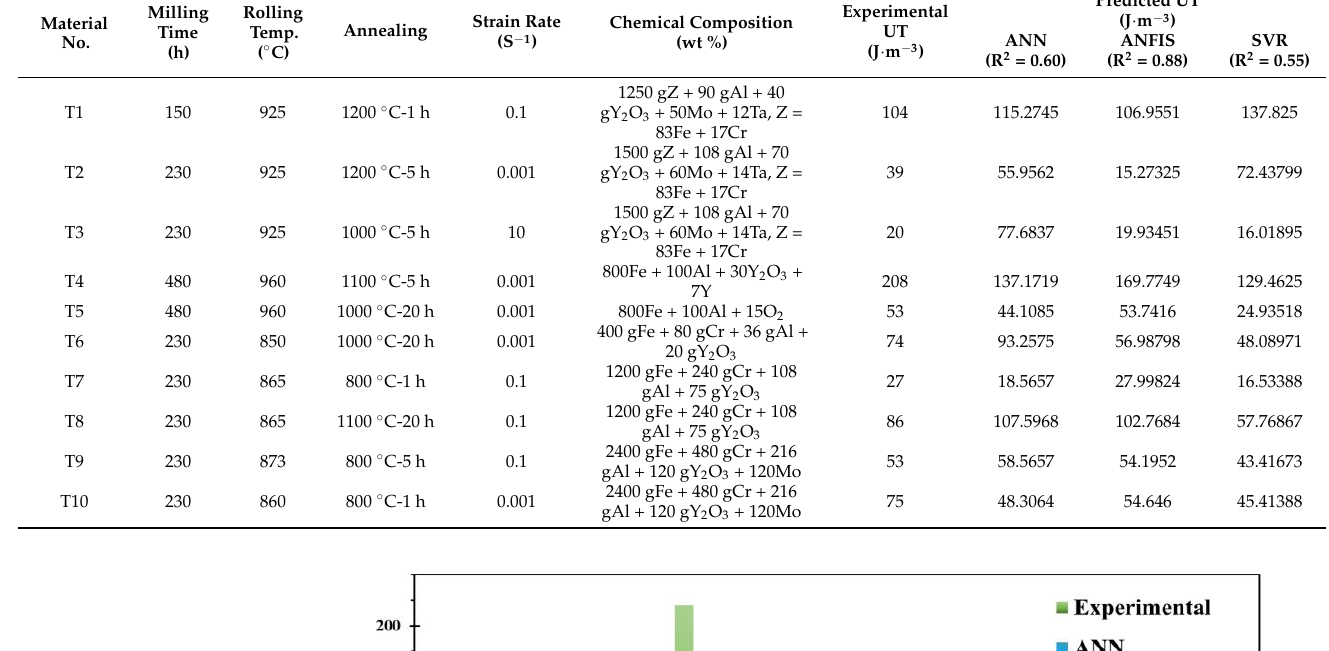
than the other models.